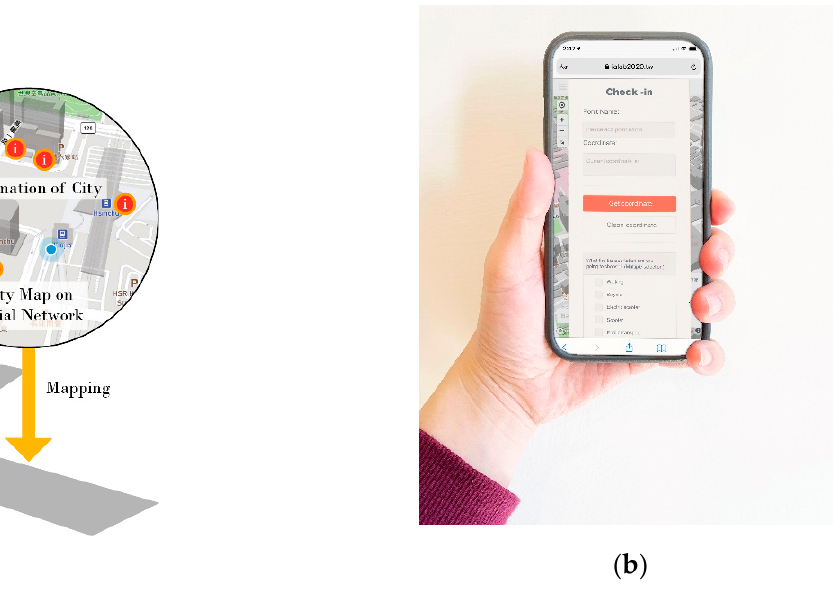
Figure 4. Prototype display of the citizen-sensing system: ( a ) checking-in on the social network and obtaining current location information on a mobile device; ( b ) collecting citizen feelings through questionnaire after marking location coordinates.